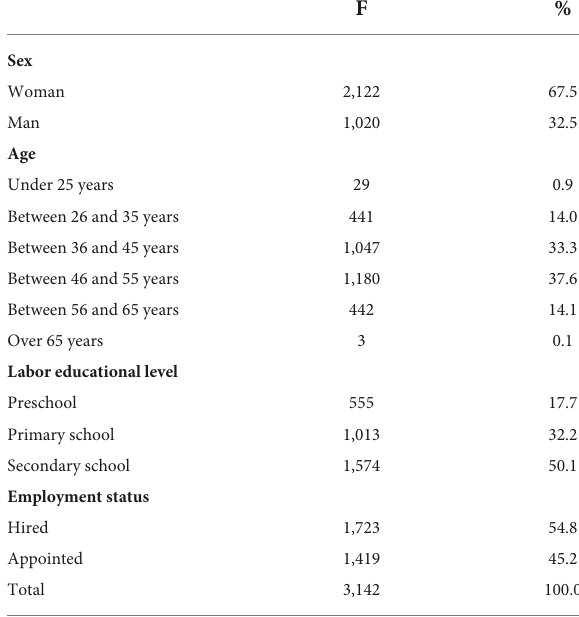
TABLE 1 Sociodemographic data of the